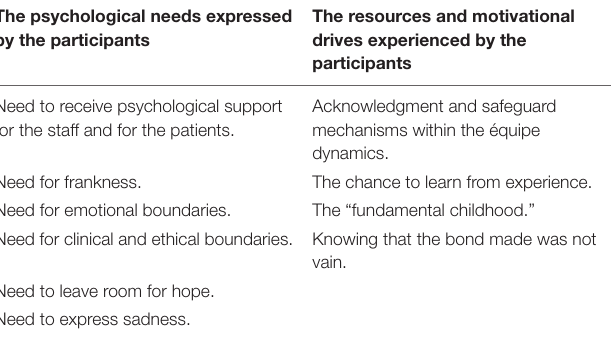
TABLE 1 | A synopsis of the phenomenological categories derived from the testimonies, related to the two thematic domains of the psychological needs and resources of the